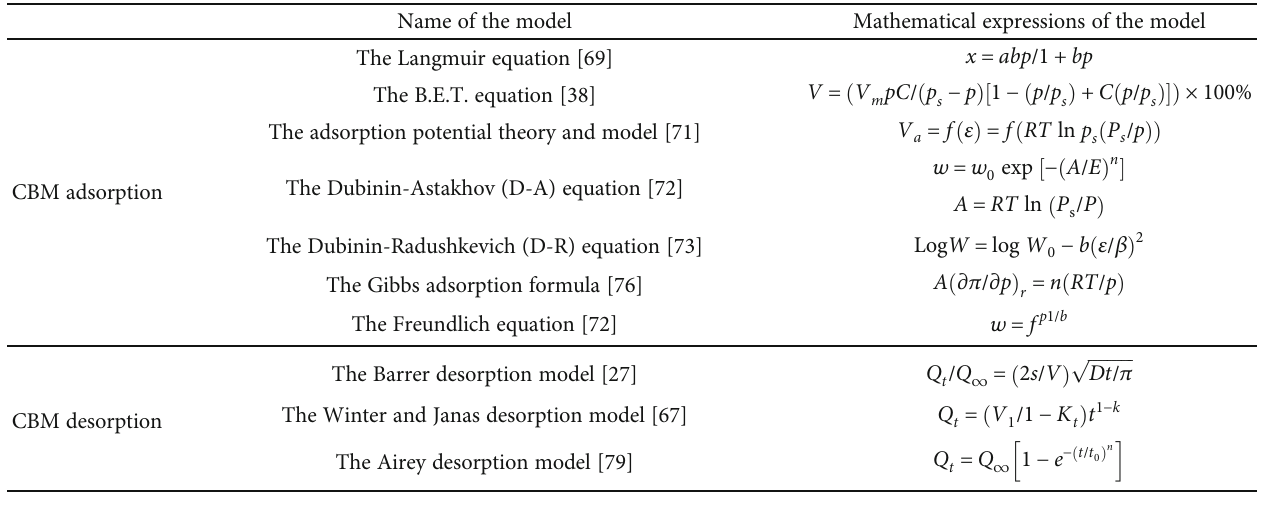
Figure 10: CH isothermal adsorption curves measured using the volumetric method and the NMR method (a), the cross plot of the 4 spectra distribution of anthracite coal (c) and high Langmuir volume from the volumetric method and the NMR method (b), and T 2 volatile bituminous coal (d) after di ff used water and added water treatments (modi fi ed from Yao et al. [44], Zheng et al. [65], and Wang et al. [66]). Table 2: CBM adsorption/desorption models and mathematical expressions.